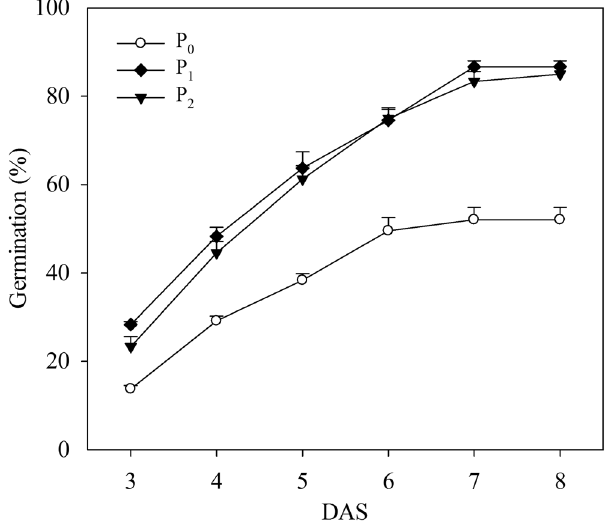
Figure 6. Germination dynamics of pelleted rice seeds in two pelleting treatments under waterlogging conditions in Field. P 0 : non-pelleted naked seeds; P 1 : Seed pelleting time of three with CaO 2 content of 20% in formula 1; P 2 : Seed pelleting time of three with CaO 2 content of 20% in formula 2. The seed germination data were recorded from 3 DAS until constant at 8 DAS. Error bars indicate standard error (n = 4).